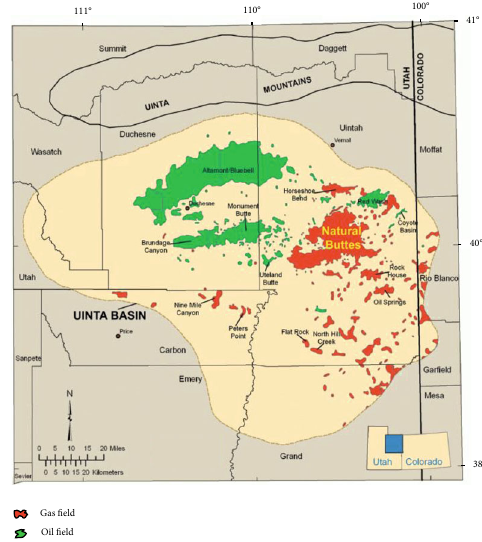
Figure 1: Map showing the study area of the Altamont-Bluebell fi eld in Uinta Basin